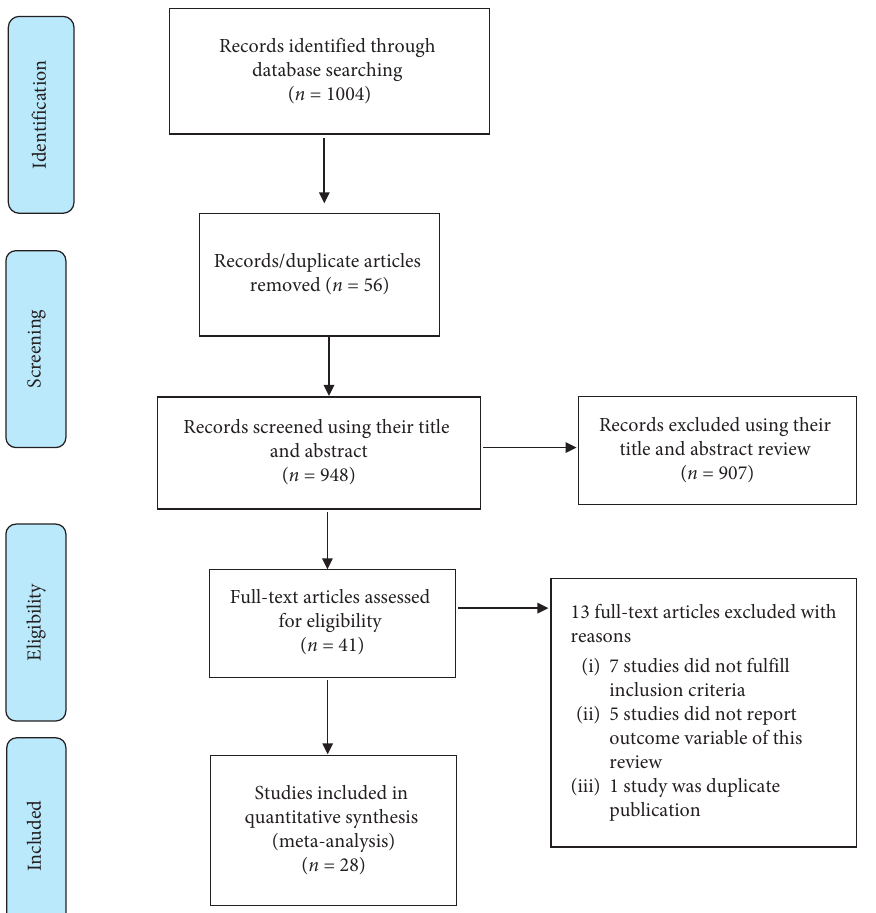
Figure 1: Flow diagram of the studies included in the